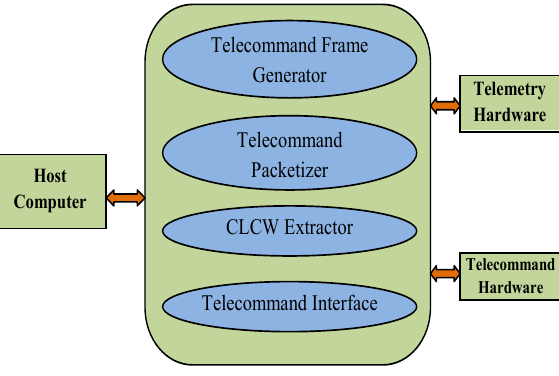
Figure 6. TTCP TC Frame Generator & Transmitter sub-